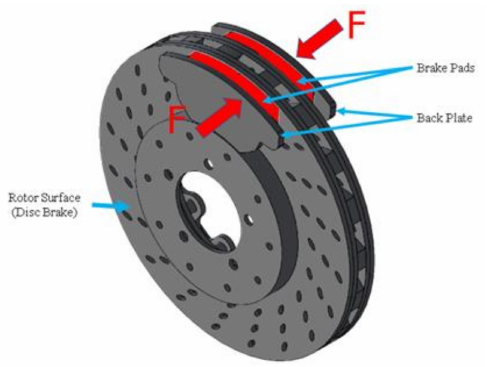
Figure 1. Force of friction between the brake pads and the rotor surface.